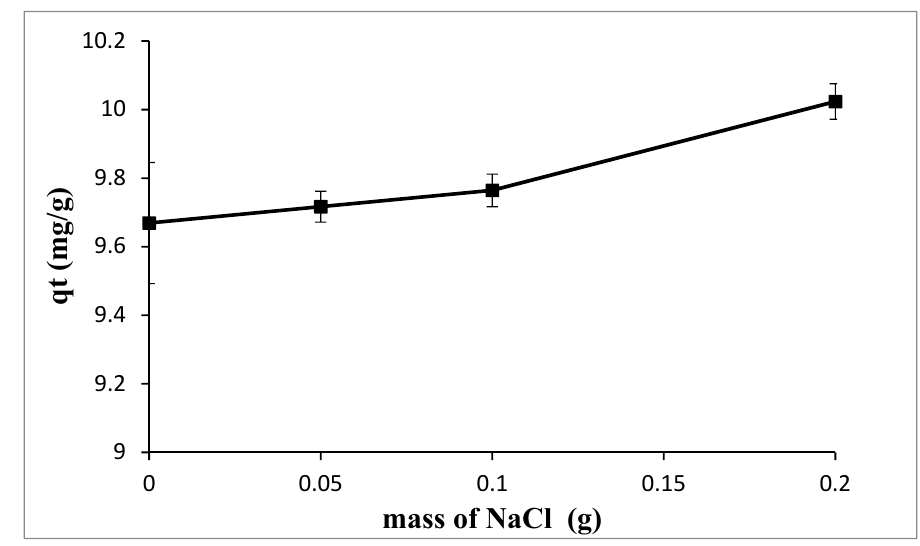
Figure 11. The effect of NaCl addition on adsorption of TPC using 1% by weight adsorbent dose, 124 mg/L initial TPC concentration, at temperature of 295 K, pH of 5.0, and contact time of 24 h.